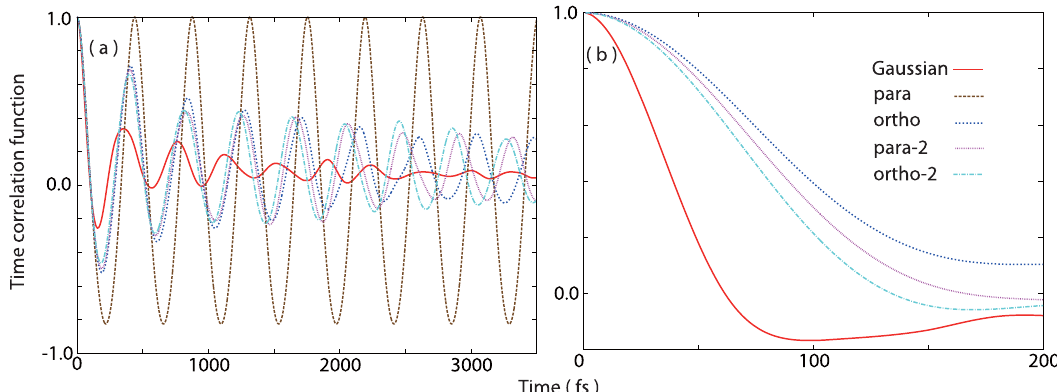
Fig. 4 Real-time translational and orientational dynamics of hydrogen molecules during the collision with CNT(15,0). a TCFs of the position of the COM R COM ( t ) and b TCFs of the time-dependent angle θ ( t ) between the molecular axis and the CNT(15,0) surface as a function of time in CNT-45. The θ - TCF for para is omitted because para is completely spherical and does not have any orientational degree of